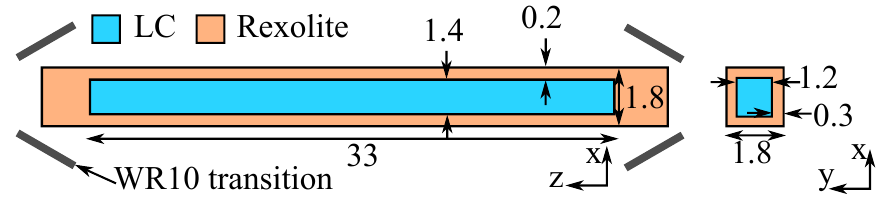
Figure 6. Cross section of an LC sWL phase shifter for W-band [20]. All dimensions are given in mm.